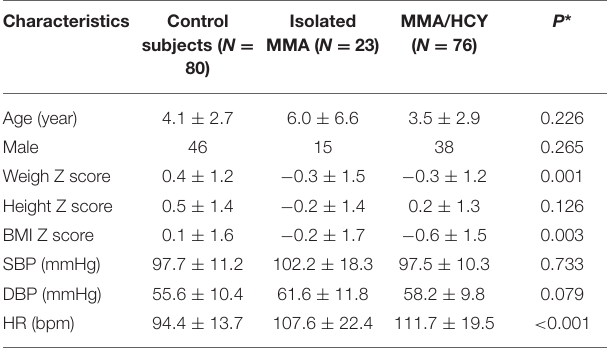
TABLE 1 | Baseline characteristics of control, isolated MMA, and MMA/HCY groups.